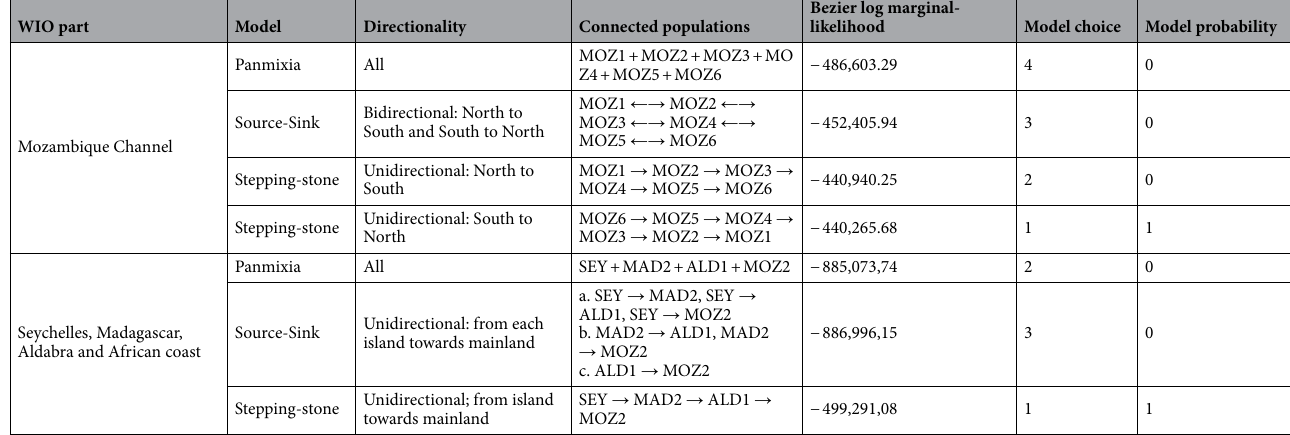
Table 4. Comparison of migration models on the directionality along the Mozambique Channel and between the islands Seychelles, Madagascar, Aldabra and East Africa mainland. The model with highest support is highlighted in grey. Connected populations with + means all directions, ←→ refers to bidirectional and → or ← to